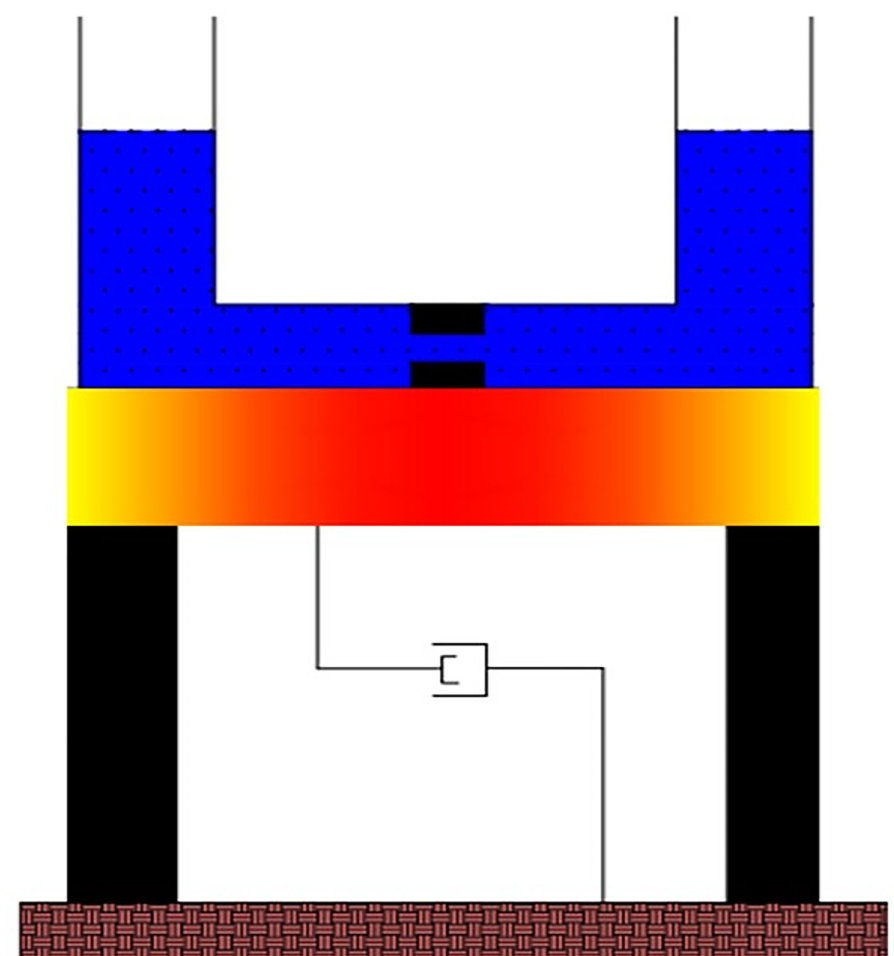
Fig 1. Schematic view of Tuned Liquid Column Damper (TLCD) on an SDOF system. damping, and stiffness of the structure equipped with TLCD, and f is the external loading. ext ( t ) The single and double dots in the superscript of variables present velocity and displacement respectively. Equipping MDOF structure with TLCD, the structure parameters associated with the degree of the freedom of MDOF structure on which TLCD is placed should be considered in Eq (2). Like an MDOF structure equipped with TLCD at the top of its fourth storey. Then in Eq (2), m , k and c will be the mass, stiffness, and damping of the fourth storey respectively. s s s The generalized matrix form for governing equations of motion for n th MDOF structures can be expressed as: In the above Eq (3), [M], [C], and [K] are the mass, stiffness and damping matrix respec- tively having order n+1 � n+1, where n represents the degree of freedom of the host structure and 1 is for the degree of freedom of TLCD. f € x g , _ f x g , { x }, and { z } are the acceleration, veloc- s s s ity, displacement, and influences co-efficient vectors respectively.